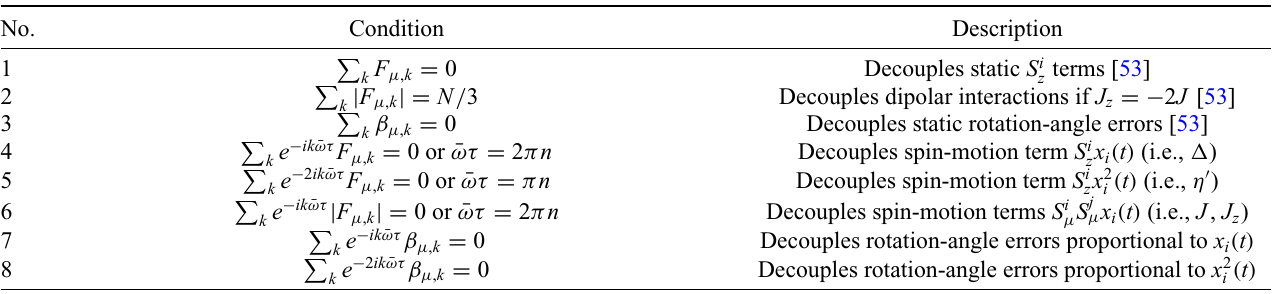
TABLE III. Conditions for decoupling from static Hamiltonian terms ( 1, 2, 3 ) and spin-motion coupling (4–8). Each condition must be satisfied for all μ ∈ { x , y , z }